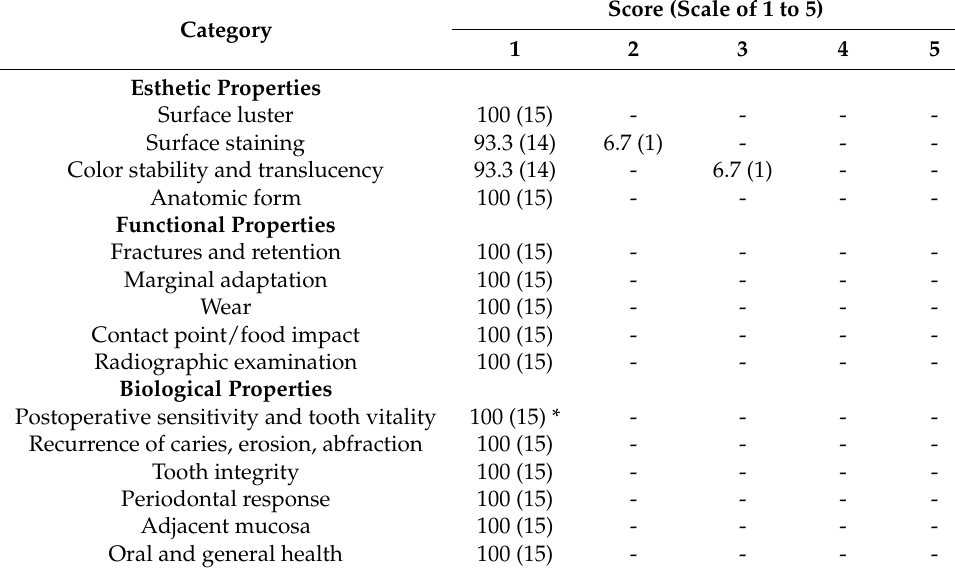
Table 8. Distribution of scores according to the FDI criteria for esthetic, functional, and biological properties after 6-month follow-up, in percentage (n =